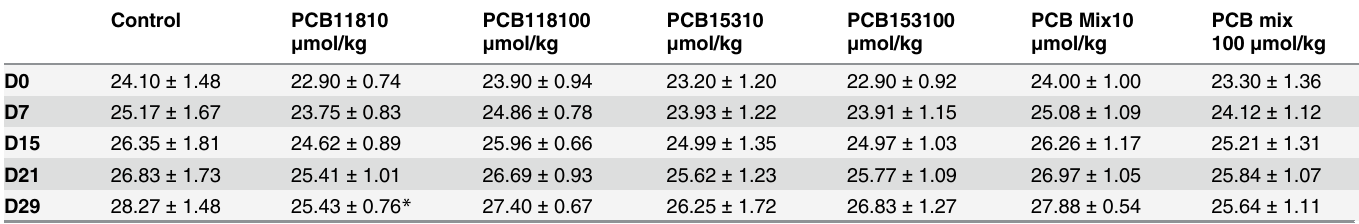
Table 2. Changes in body weight in the different groups ( * p < 0.05).